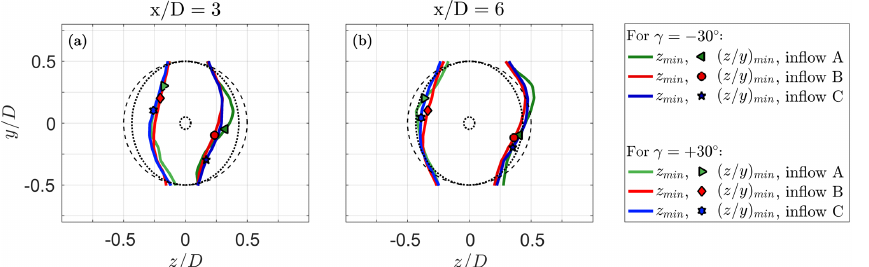
Figure 7. Minimum values in streamwise velocity u/u ref . Curl shapes and minimum positions are presented at x/D = 3 (a) and x/D = 6 (b) for the three different inflow